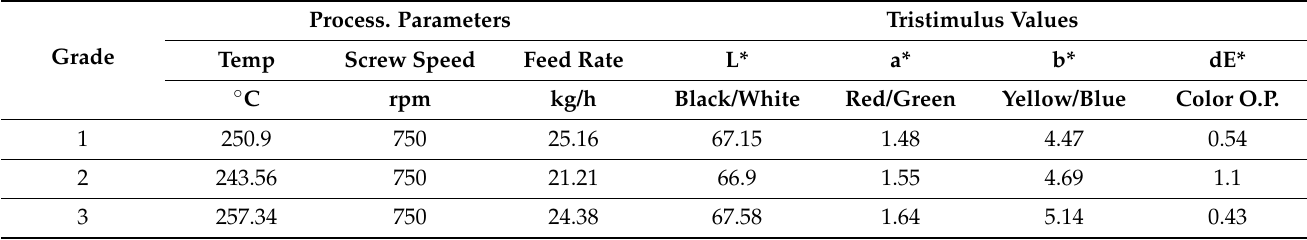
Table 6. Simulate tristimulus color solutions.